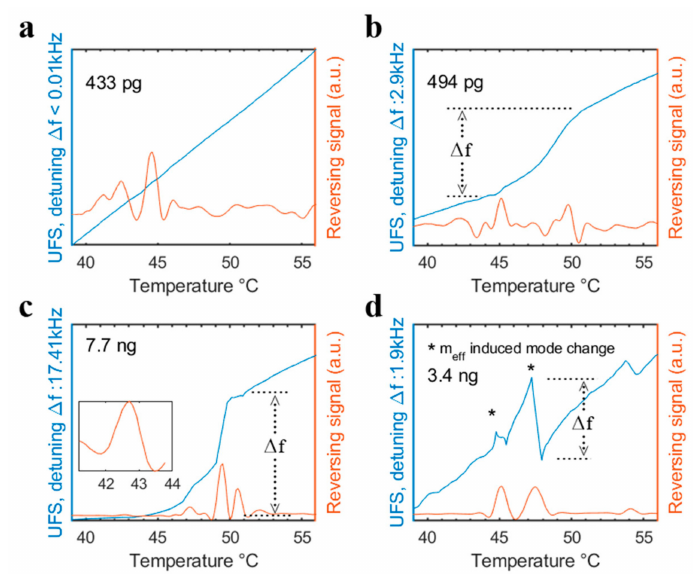
Figure 8. Comparison of modulated MTA signals during the Tg at low ( a and b ) and large ( c and d ) sample sizes. ∆ f marks the maximum detuning during the Tg. The inset in c shows a zoomed-in section of the reversing signal at the Tg onset.